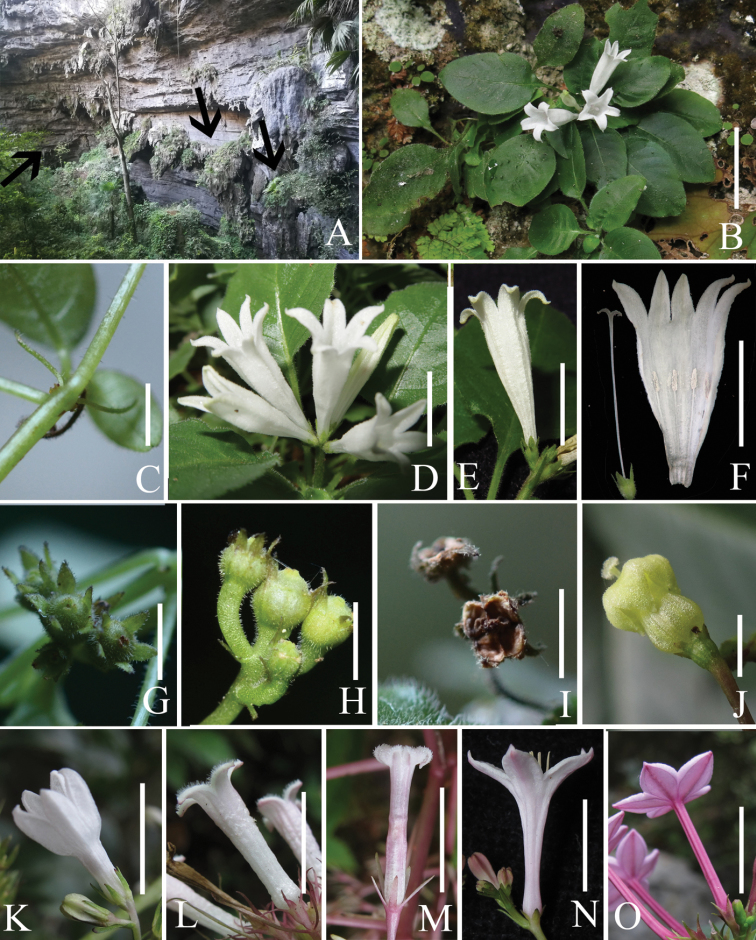
Spiradiclis
tubiflora. A Habitat (the arrow shows the place of growth) B Habit C Stipule D Inflorescence, lateral view E Flower, lateral view F Corolla opened to show floral parts G Capsules, frontal view H Capsules, lateral view I Matured capsules with four valves. Flowers of selected Spiradiclis species, lateral views: JS.
longipedunculataKS.
fuscaLS.
malipoensisMS.
baishaiensisNS.
glabraOS.
coccinea. Scale bars: 1 cm (B, D, E, F, K, L, M, N, O); 3 mm (C, G, H, I, J). Photos by Bo Pan, Jing Liu and Lei Wu.